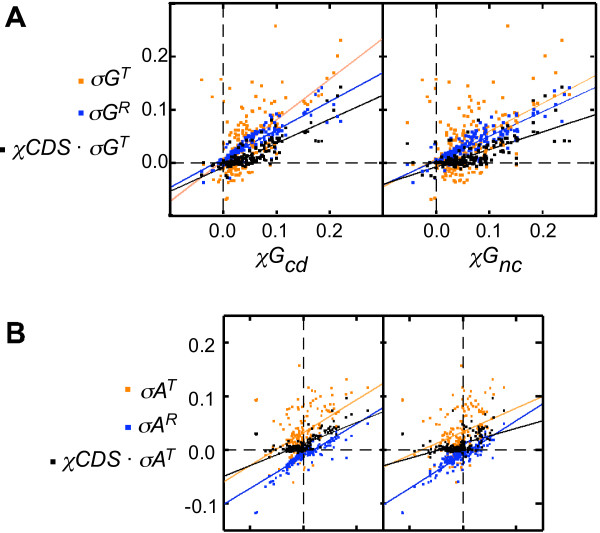
Correlation analysis of RAP and TAP. (A) Correlation between σGR (blue symbols), σGT (red symbols), and χCDS·σGT (black symbols) to χGcd (left panel) and to χGnc (right panel). (B) Correlation between σAR (blue symbols), σAT (red symbols), and χCDS·σAT (black symbols) to χAcd (left panel) and to χAnc (right panel). The slopes (m) and correlation coefficients (r) of the regression lines are listed in Table 2.